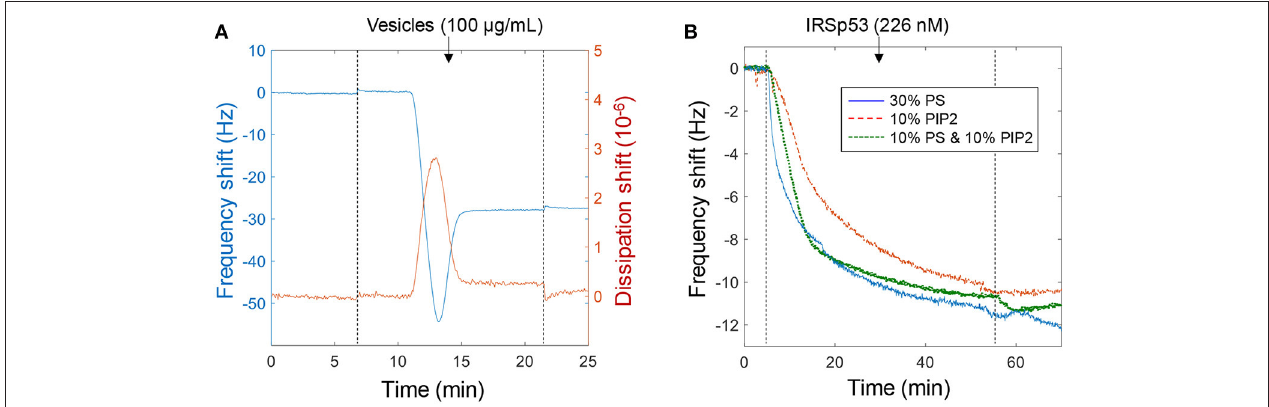
FIGURE 1 | Using QCMD to verify the biomolecular interaction. (A) Example of bilayer formation on planar SiO 2 with lipids containing 10% PS, 10% PIP2, and 80% DOPC. (B) Binding of IRSp53 at a relatively low concentration to different lipid compositions with negative charge (No binding was observed to pure DOPC bilayers). Note that for these curves the signal approaches ∼ 12Hz simply due to depletion of molecules in the liquid volume. Binding is irreversible as illustrated upon rinsing (dotted lines).